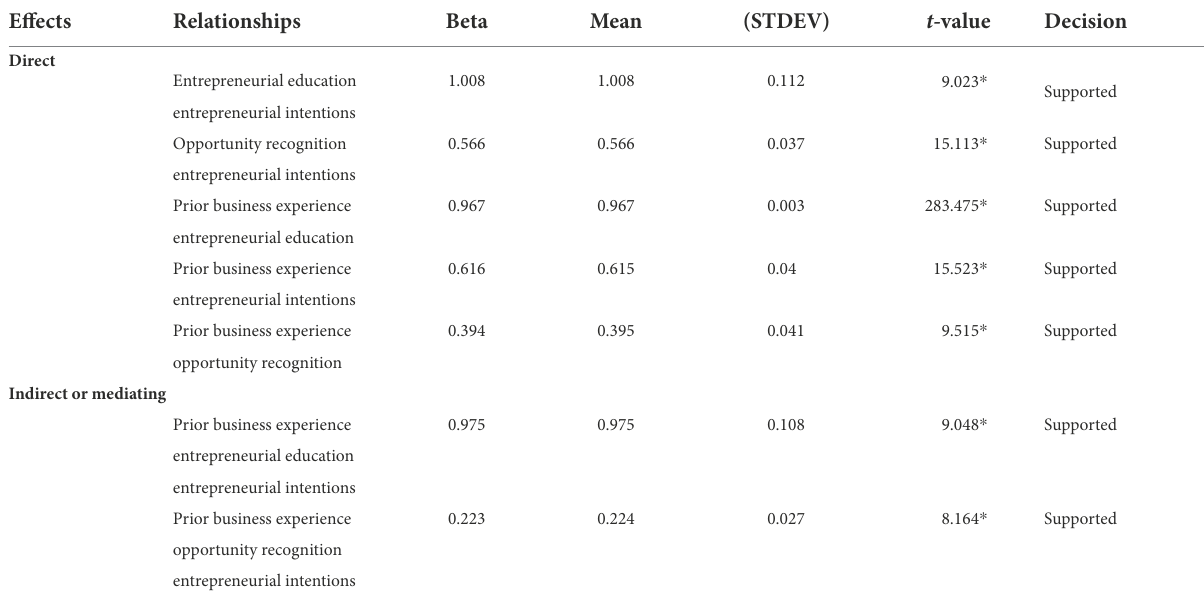
TABLE 7 Hypothesis